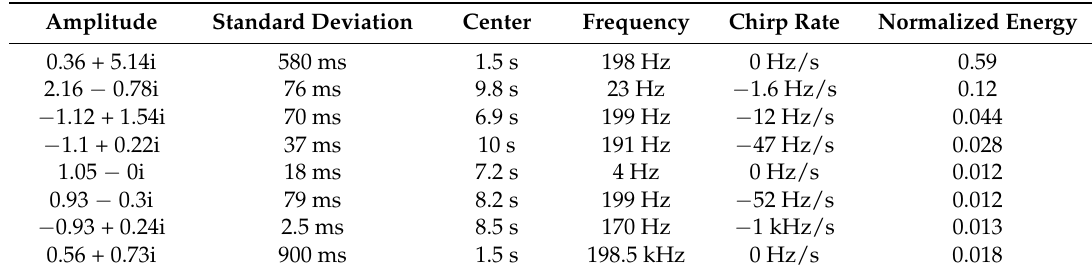
Table 1. The parameters of detected chirplets for the first six atoms of the chirplet dictionary. The approximation was conducted for the measured signal representing the MFD in the surroundings of the ship’s motor drive during manoeuvers [18].